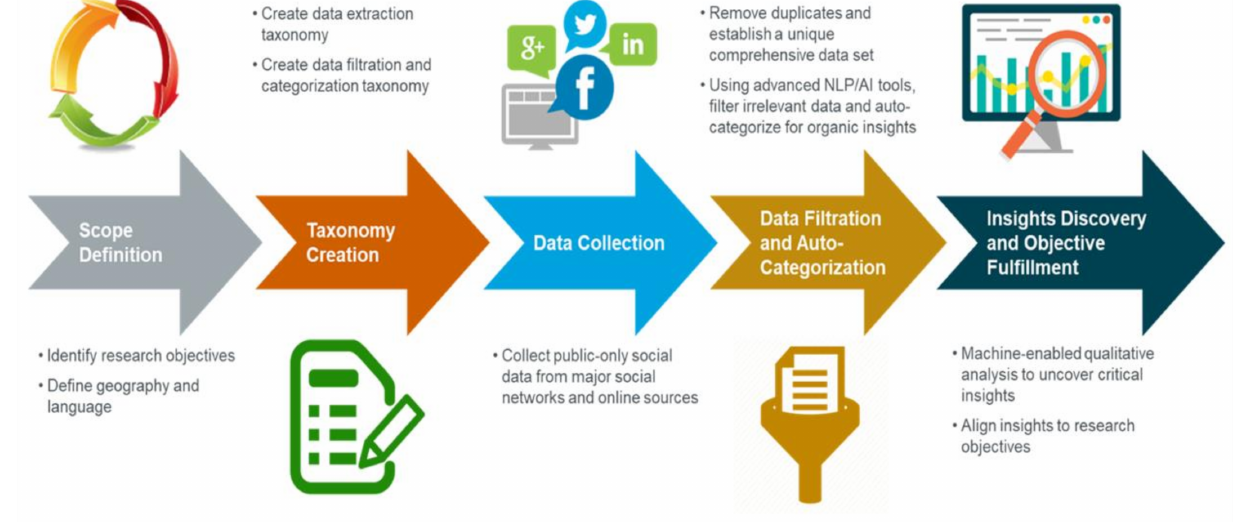
Figure 9. Social media listening, an overview of the methodology